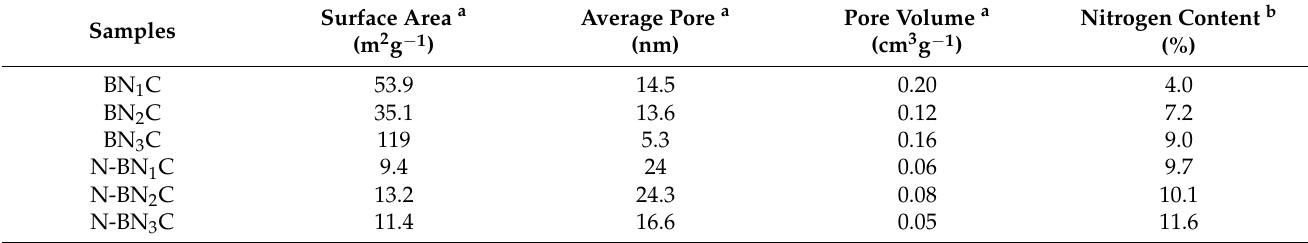
Table 1. Pore structure and nitrogen content of BN x C and N-BN x C.